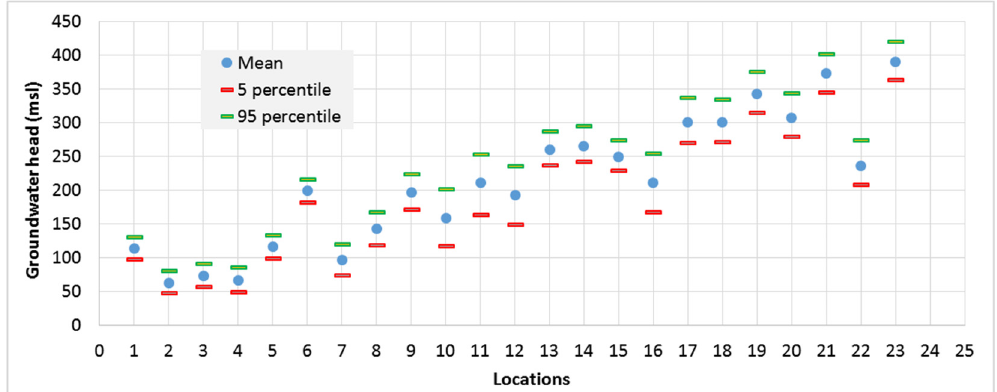
Figure 19. Mean, 5th percentile, and 95th percentile of groundwater head at 23 selected locations. Table 1. Total optimal abstraction for the five identified strategies.